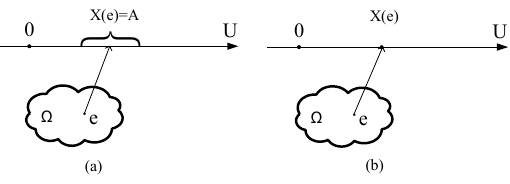
Figure 1.Comparison between (a) random set and (b) a random variable.